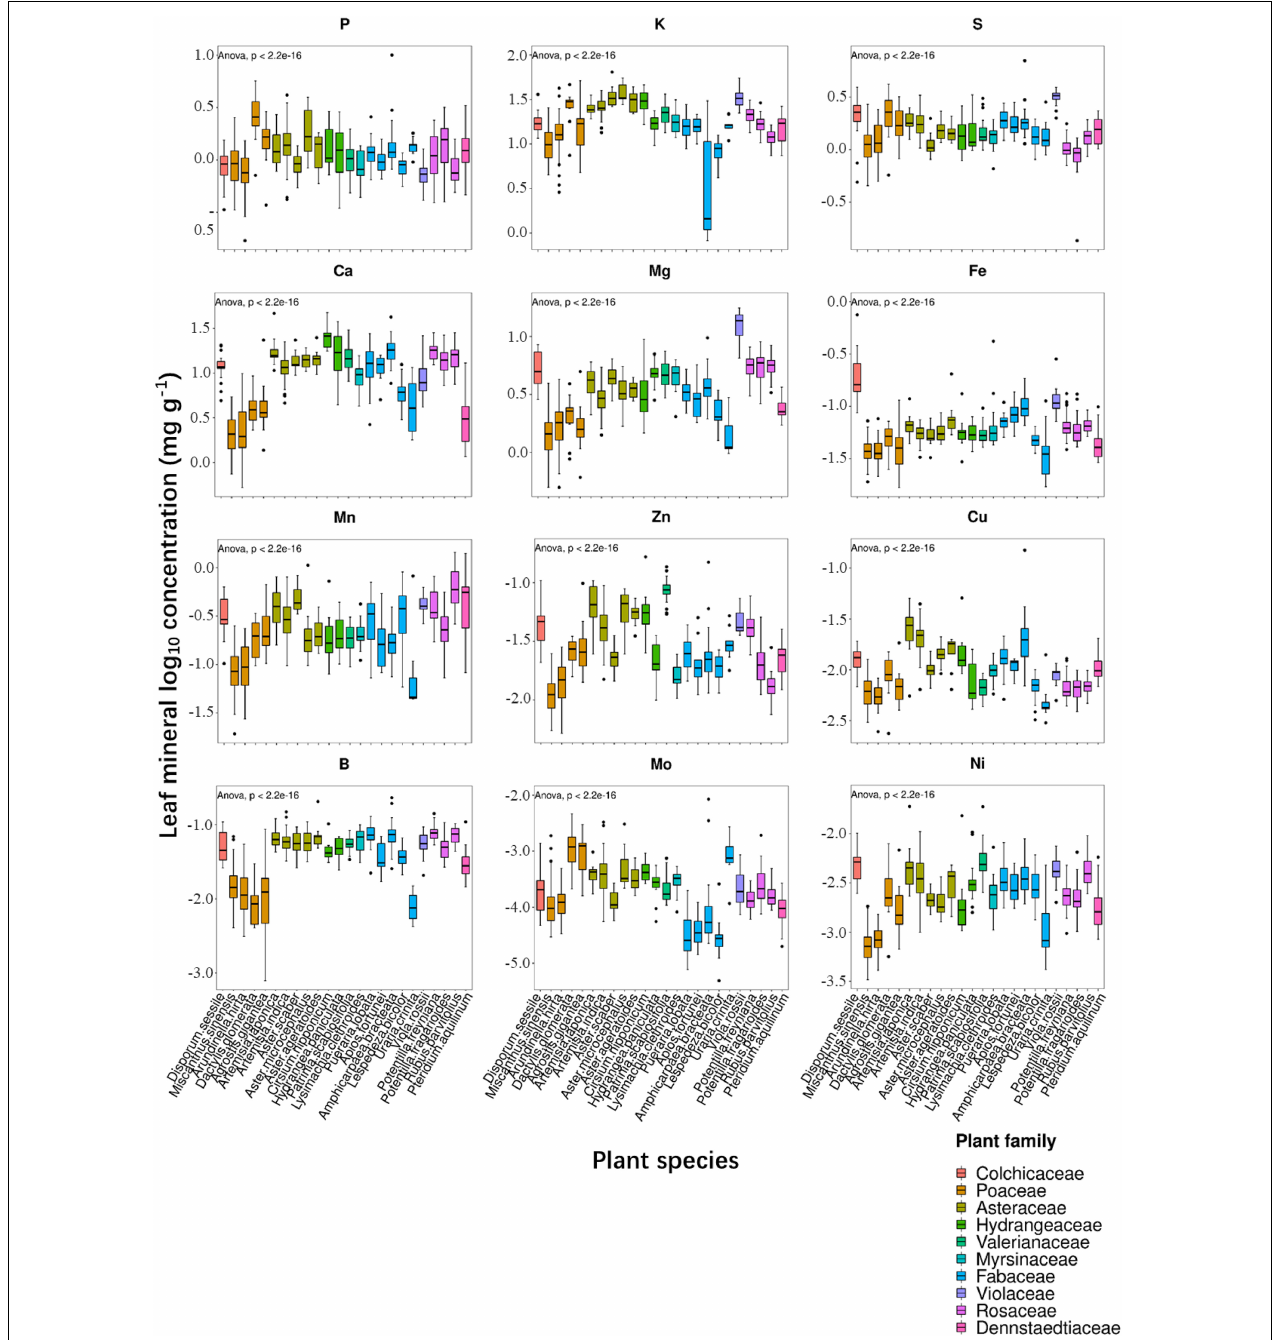
FIGURE 2 | Boxplot showing leaf log 10 concentrations of 12 essential elements (P, K, S, Ca, Mg, Fe, Mn, Zn, Cu, B, Mo, and Ni) of diverse plant species. Different box colors represent various plant families (as indicated below). Species from left to right: Disporum sessile , Miscanthus sinensis , Arundinella hirta , Dactylis glomerata , Agrostis gigantea , Artemisia japonica , Artemisia indica , Aster scaber , Aster microcephalus , Aster ageratoides , Cirsium nipponicum , Hydrangea paniculata , Patrinia scabiosifolia , Lysimachia clethroides , Pueraria lobata , Apios fortunei , Amphicarpaea bracteata , Lespedeza bicolor , Uraria crinita , Viola rossii , Potentilla freyniana , Potentilla fragarioides , Rubus parvifolius , and Pteridium aquilinum .